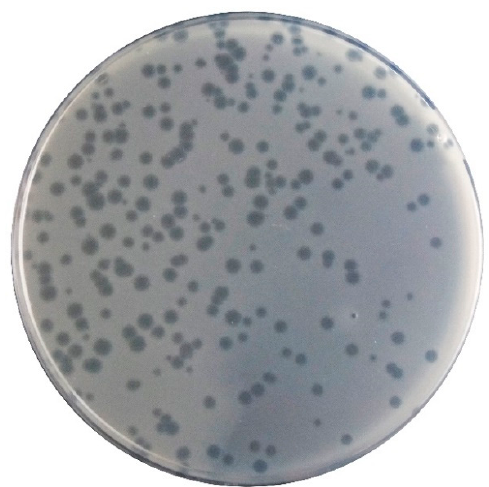
Figure 2. Morphology of the phage φ 6 lysis plaques on its bacterial host.